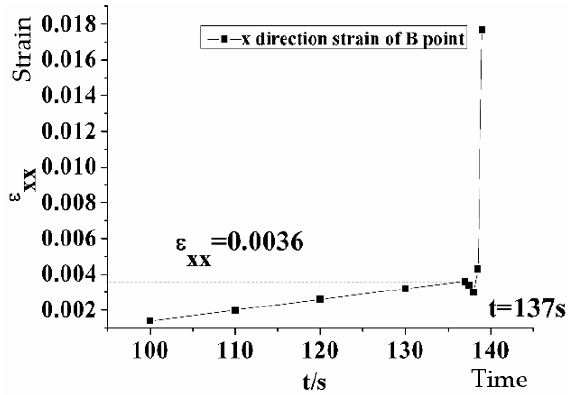
Figure 8. X-direction strain–time relationship at point B (loading rate = 0.1 MPa/s).